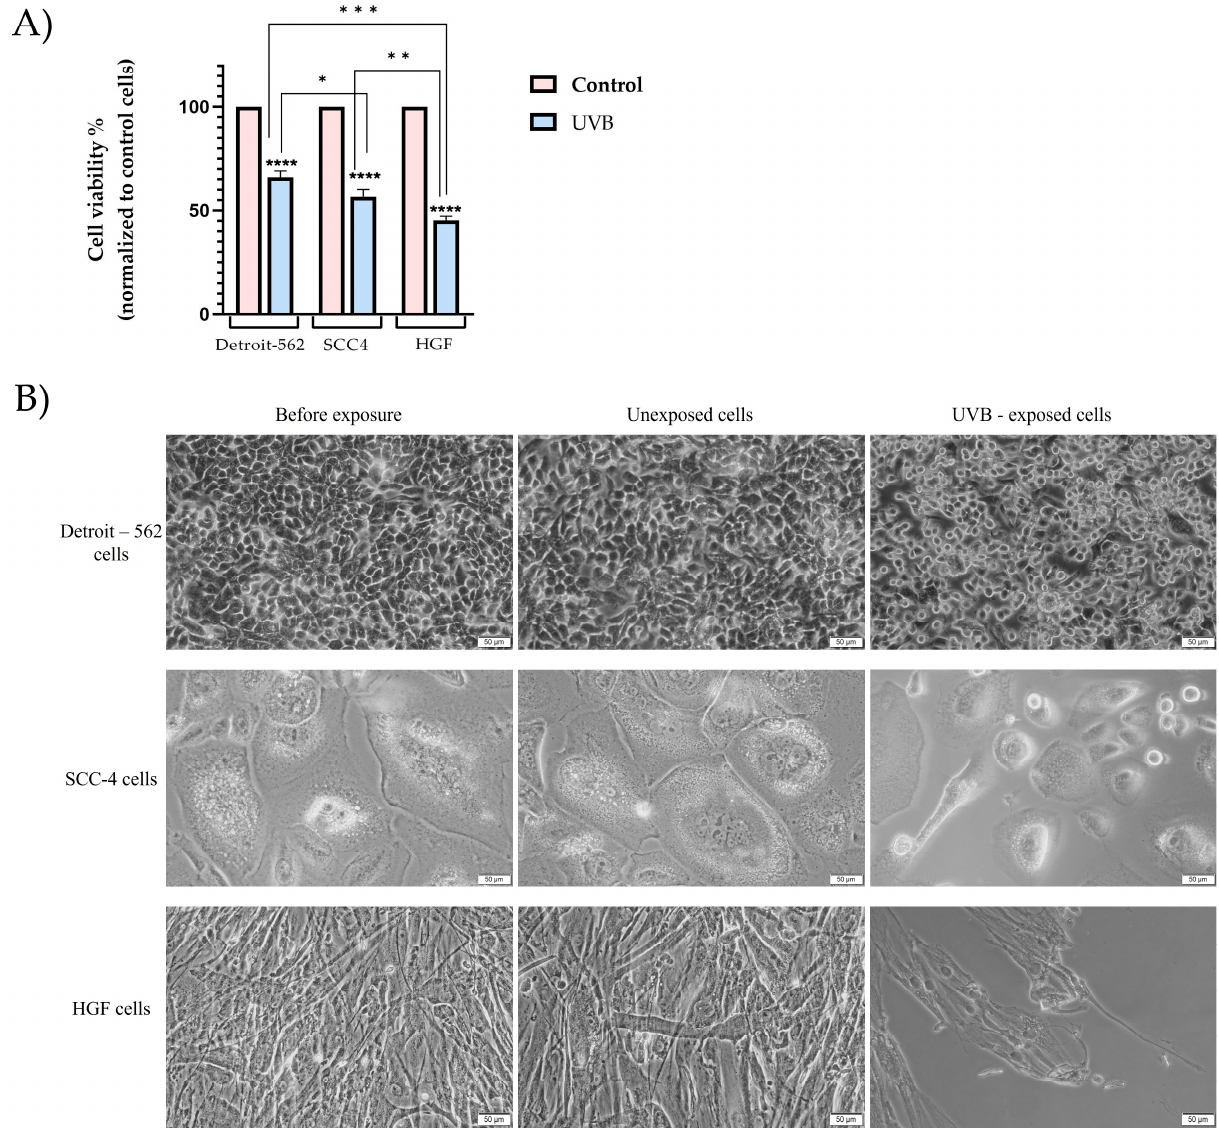
Figure 2. ( A ) In vitro assessment of the influence of UVB (5 J/cm 2 ) on the viability of Detroit-562, SCC4, and HGF cells. The MTT assay was performed immediately after UVB exposure. Data are presented as viability percentages (%) normalized to control (unexposed cells) and expressed as mean values ± SD of three independent experiments performed in triplicate. The statistical differences between the control and UV-irradiated groups were verified by applying a one-way ANOVA analysis followed by Dunnett’s multiple comparison post hoc test and the difference between the responses of each cell line was verified by applying a one-way ANOVA analysis followed by Tukey’s multiple comparison post hoc test (* p < 0.05; ** p < 0.01 and *** p < 0.001; **** p < 0.0001); ( B ) in vitro morphological changes of Detroit-562, SCC4, and HGF cells before and after exposure to UVB. The scale bar indicates 50 µ